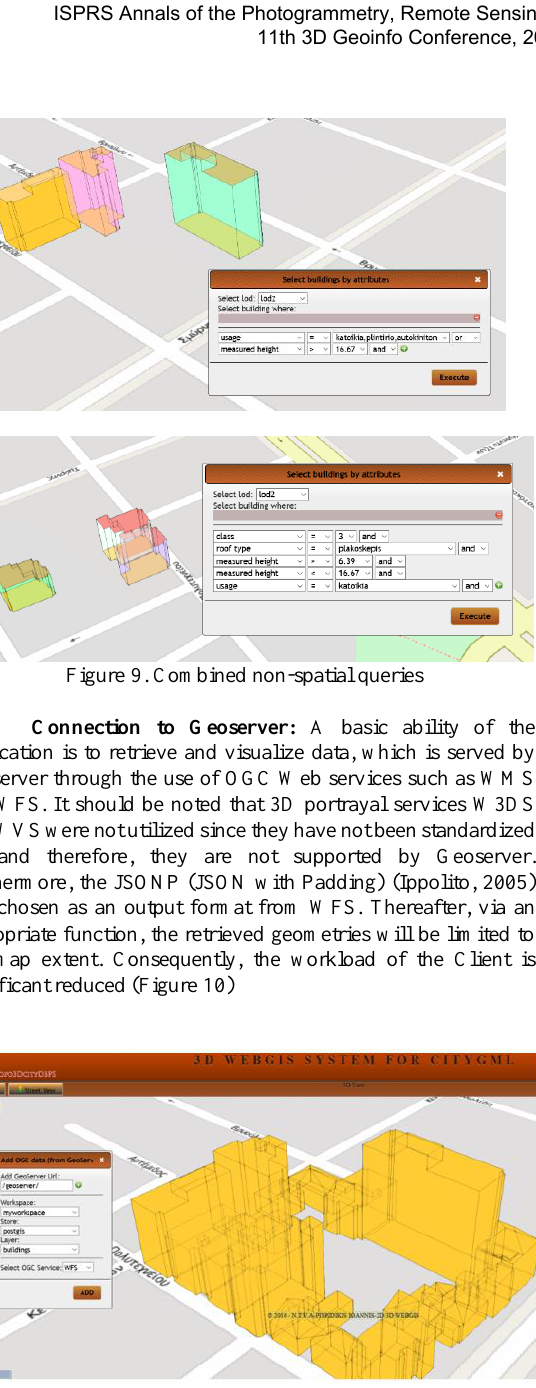
Figure 10. Retrieved data served by WFS